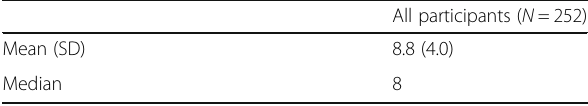
Table 2 Normative data — number of correct identities achieved in the Yearbook